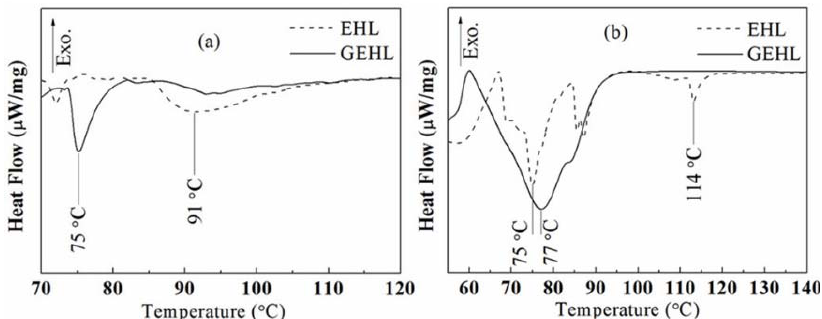
Figure 4. The reaction DSC curves of ( a ) lignin and PAPI, and ( b ) lignin and epichlorohydrin.